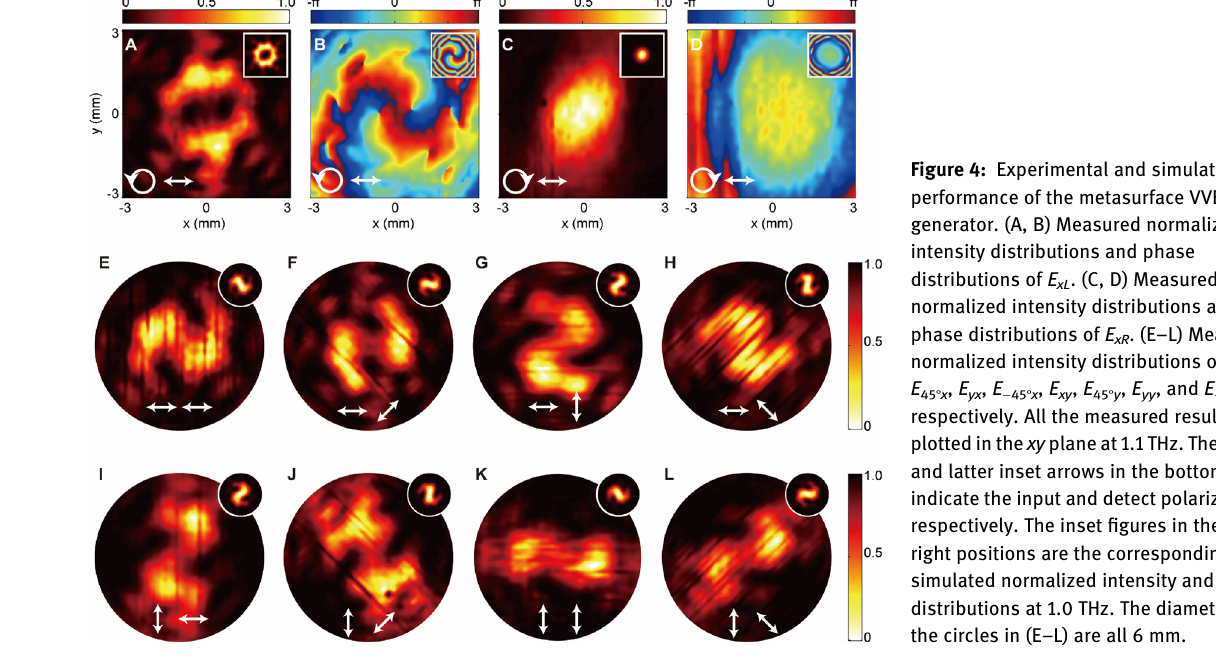
can be expressed as [37]: Ф ( r , α ) = − 2 π rNA / λ + l α , where